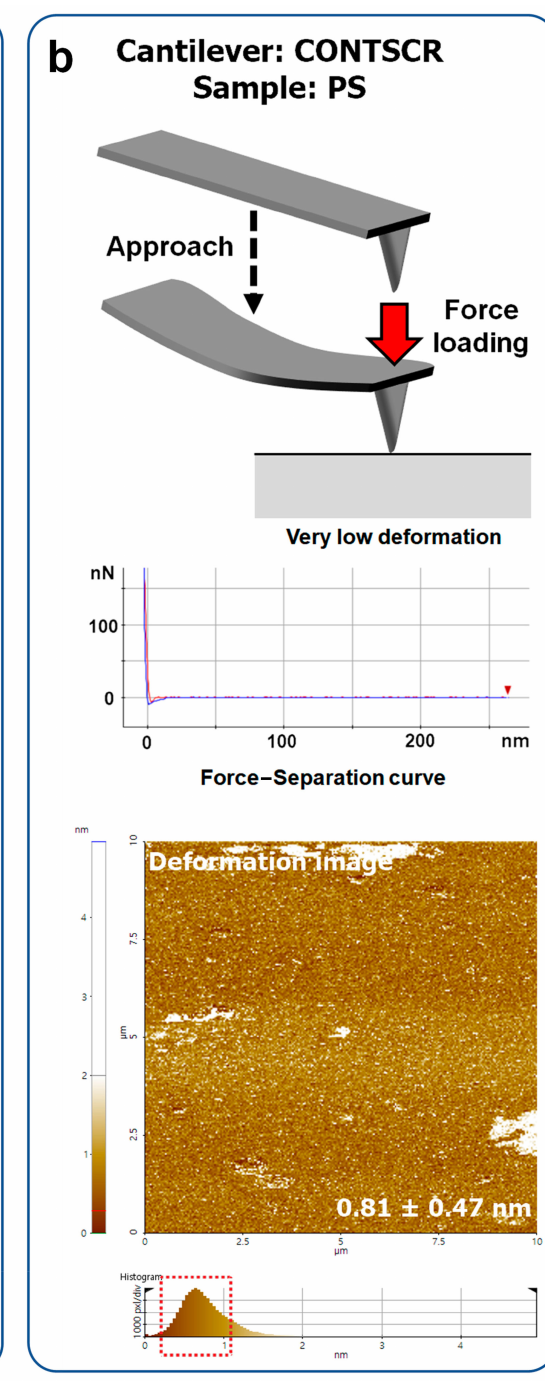
Figure 9. Sample deformation occurring during FD curve measurements. ( a ) High deformation when using a hard cantilever–soft material (NCHR–PDMS) and ( b ) very small deformations when using a soft cantilever–hard material (right,